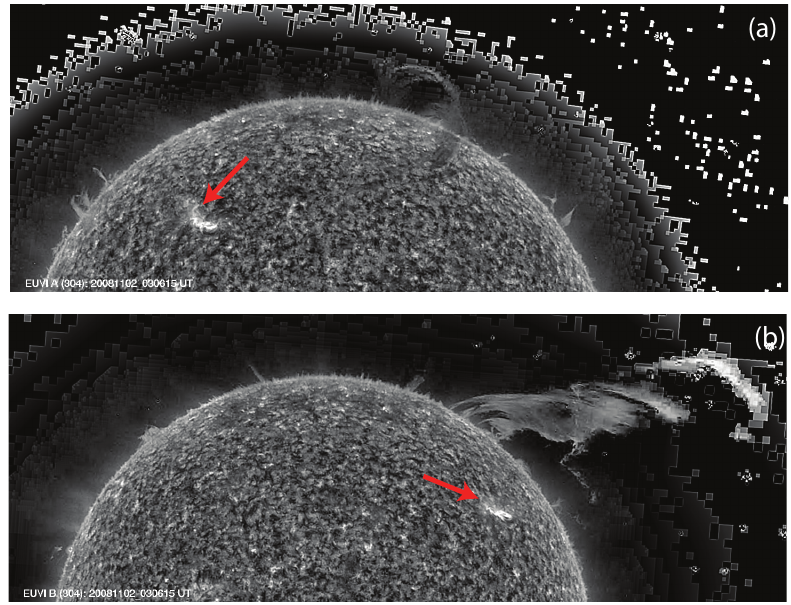
Fig. 5. Wavelet enhanced extreme ultraviolet images at 304 ˚A on 2 November 2008 at 03:06:15UT by (a) STA/SECCHI/EUVI and by (b) STB/SECCHI/EUVI. The AR 11007 that produced four B-class flares and CME2 is indicated by a red arrow.